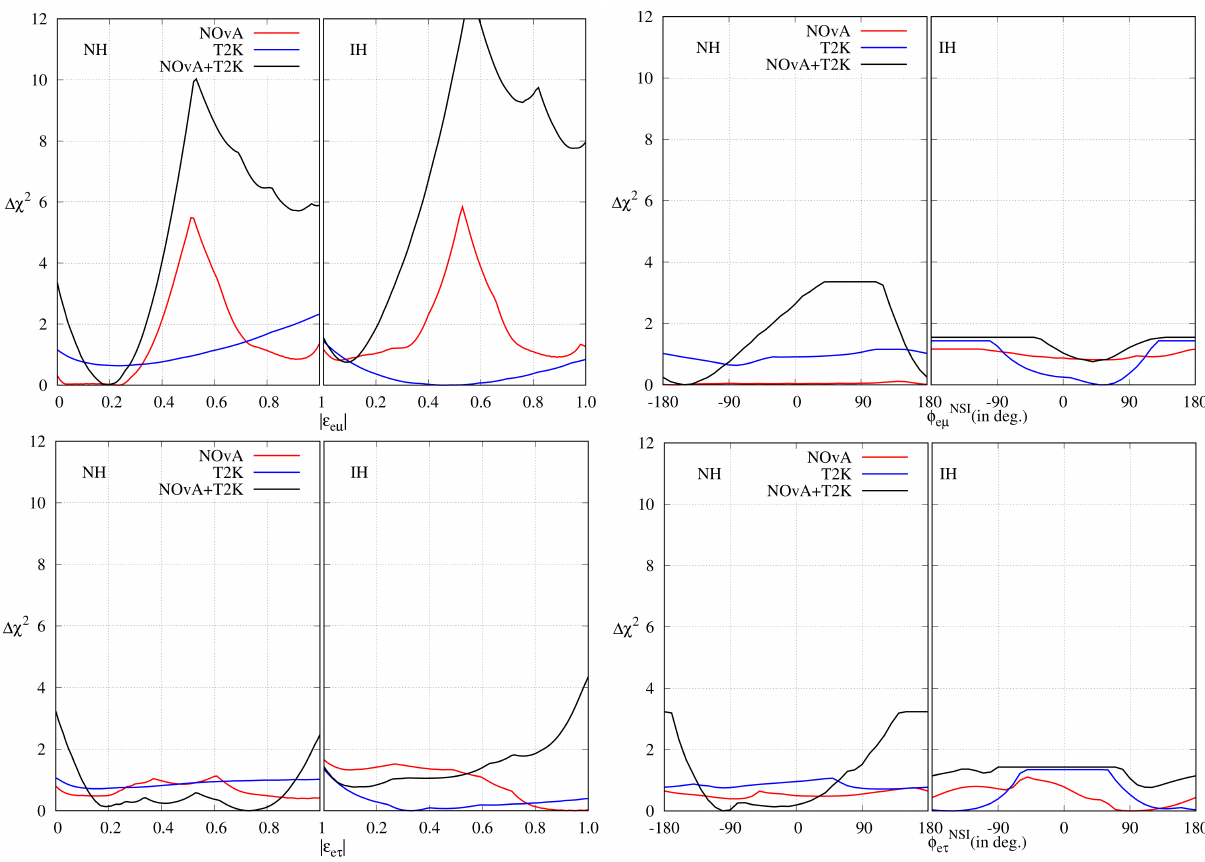
Figure 17. ∆ χ 2 as a function of individual NSI